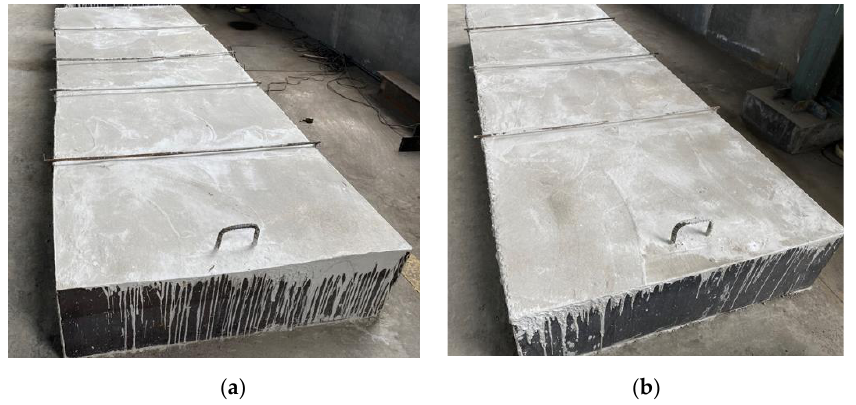
Figure 4. After pouring of the spatial reticulated grid components. ( a ) The BEJC50 × 6 component and ( b ) the JSC50 × 6 component.